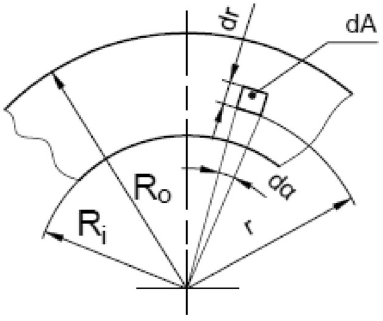
Figure 2. Presentation of annular contact area 13 .